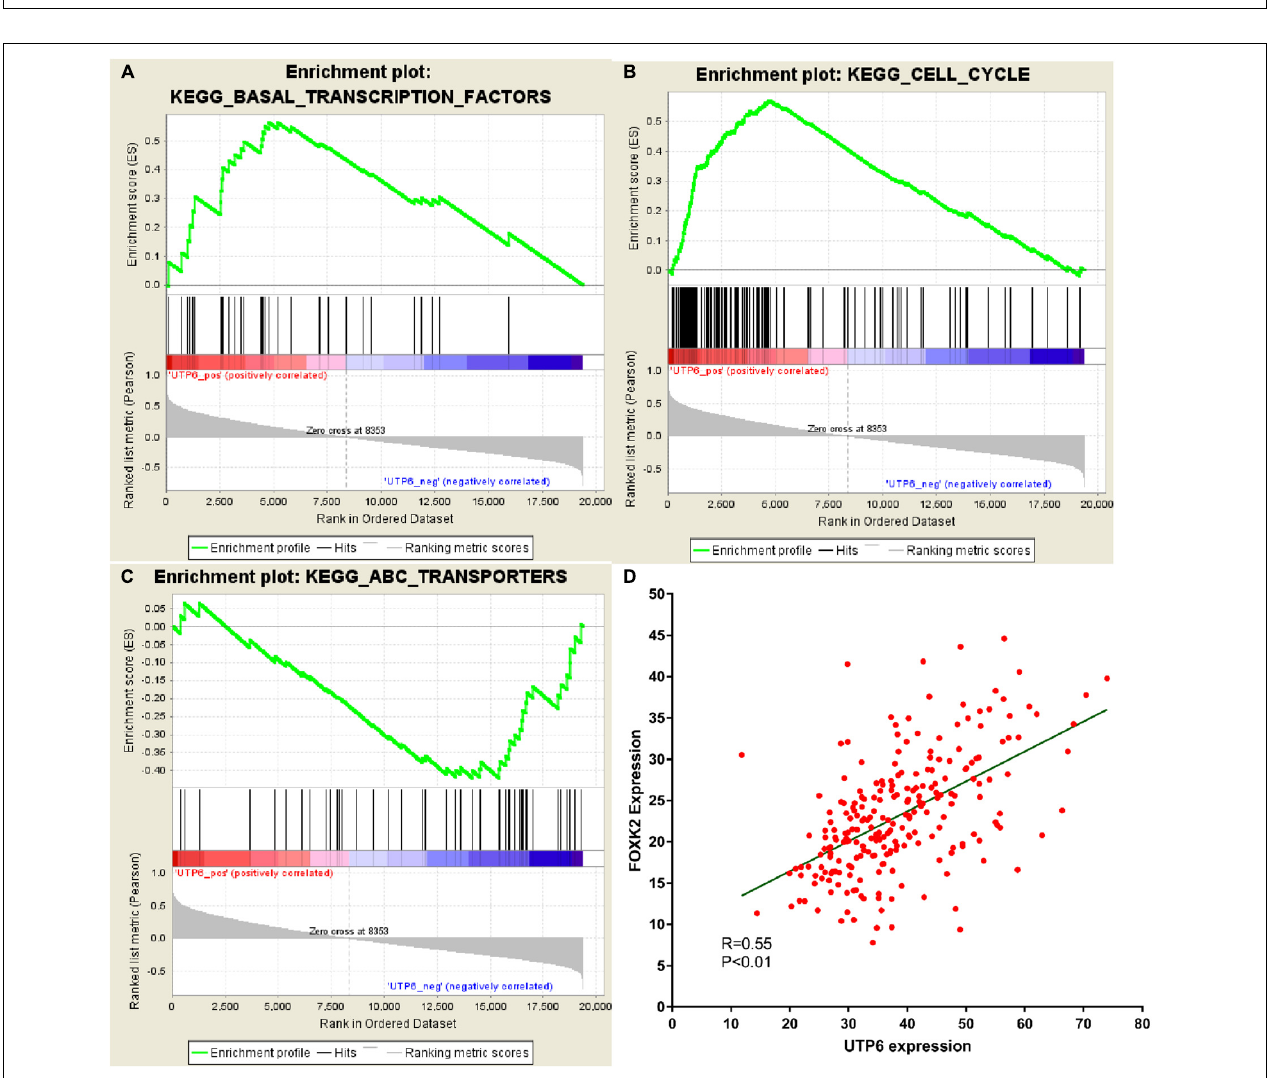
FIGURE 7 | GSEA using our data and co-expression analysis between UTP6 and FOXK2 in the TCGA colon tumor dataset. (A) Transcription factors pathway. (B) Cell cycle. (C) ABC transportanters. (D) Co-expression analysis between UTP6 and FOXK2 in the TCGA colon tumor dataset.